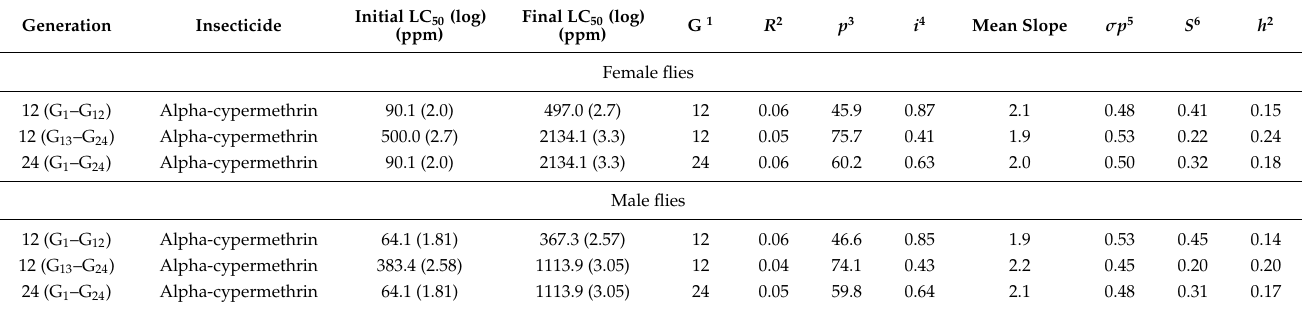
Table 5. Realized heritability ( h 2 ) for alpha-cypermethrin resistance in Alpha-Sel Musca domestica